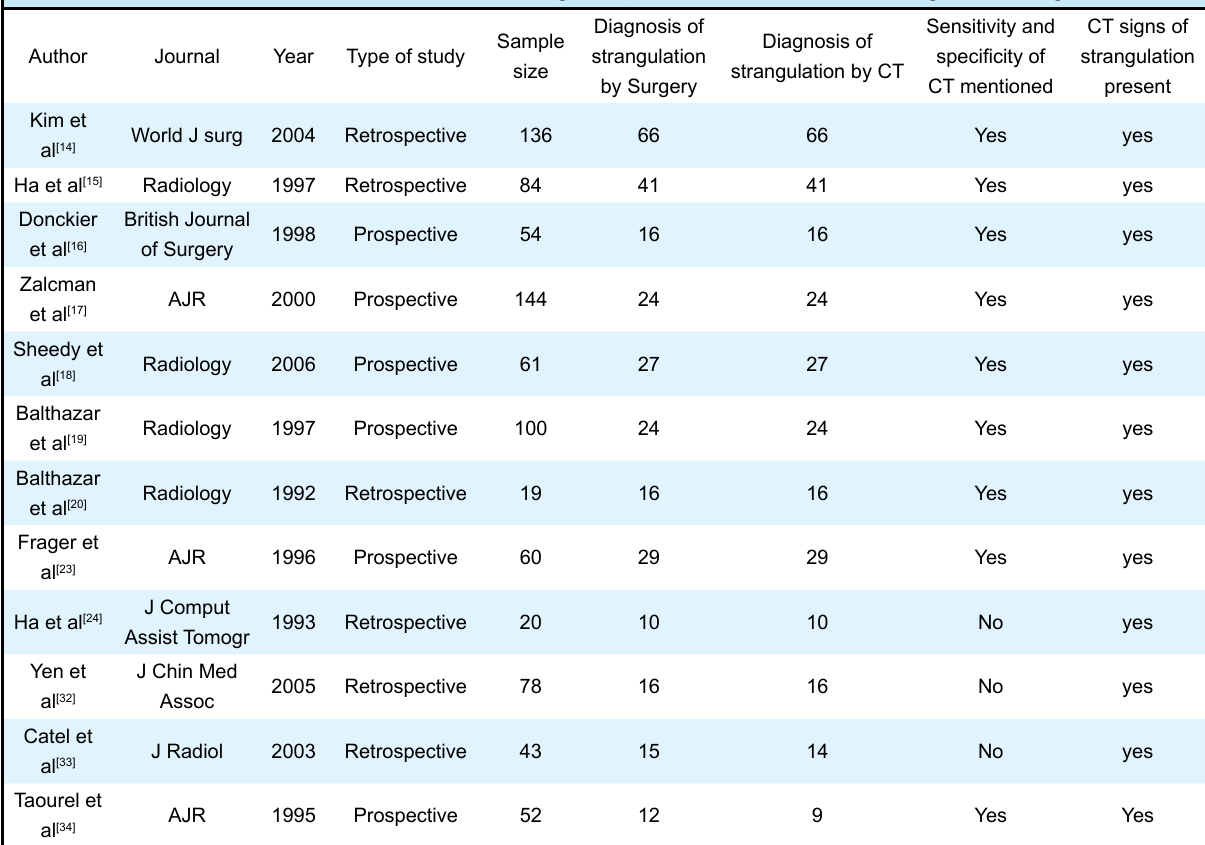
table 1. shows the studies included for review alongwith presence or absence of ct signs of